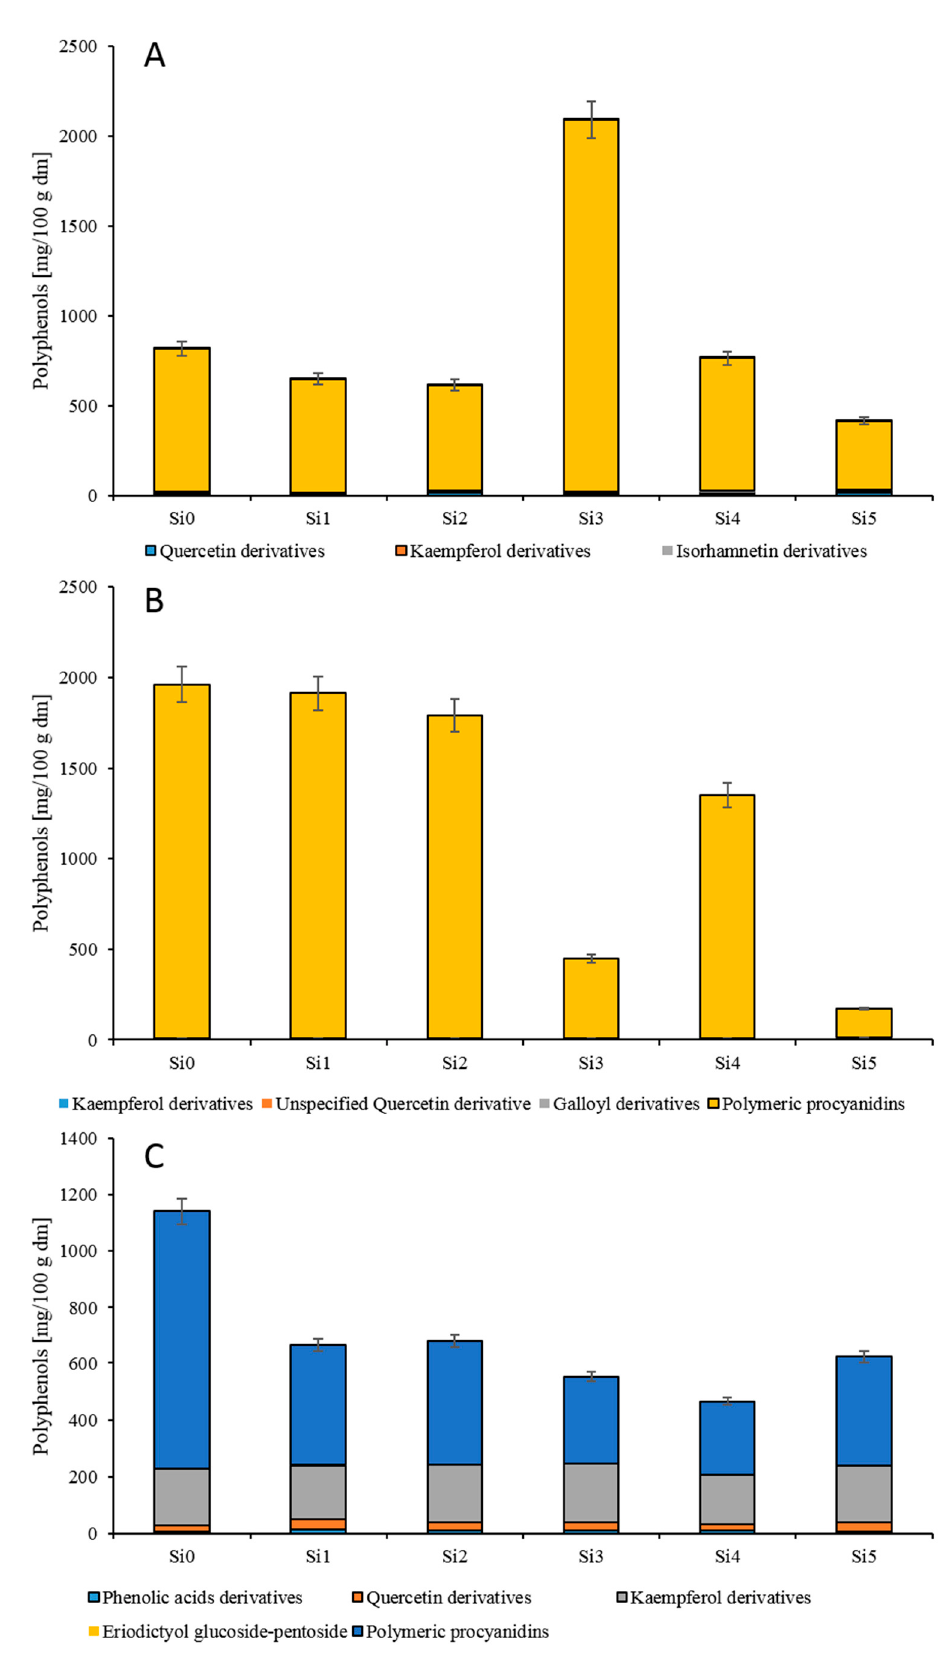
Figure 2. Polyphenolic compound content in the fruit pulp + skin ( A ), seeds ( B ), and leaves ( C ) of cherry silverberry (mg/100 g d.w.).